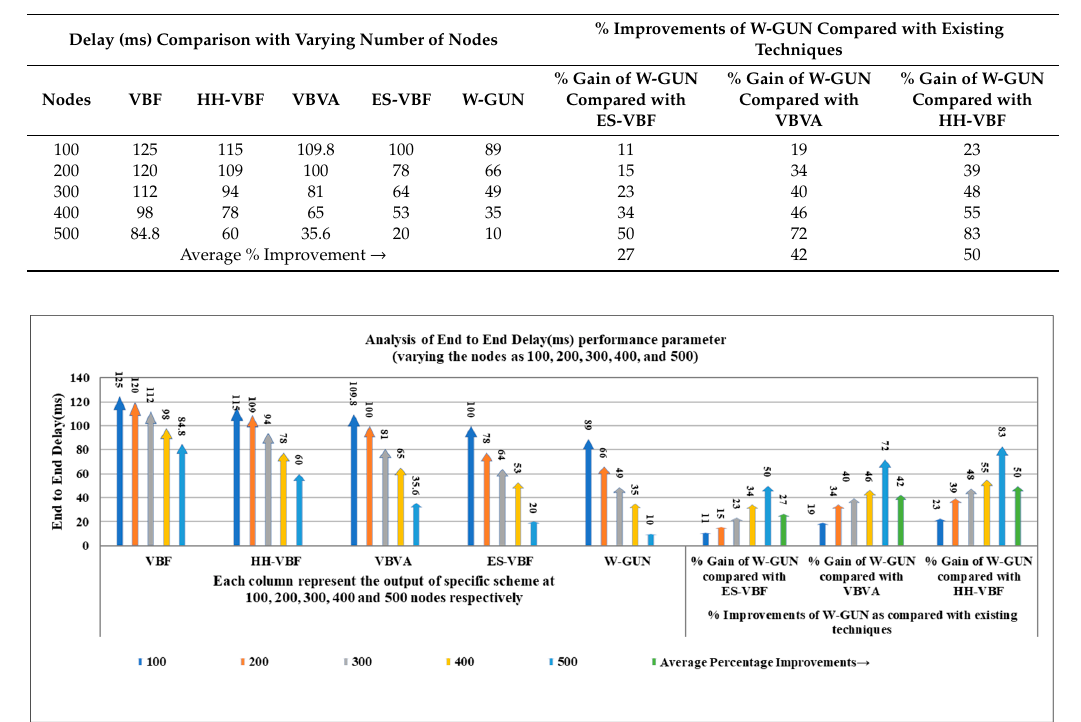
Figure 3. End-to-end delay versus the number of underwater nodes. Table 1. Descriptive performance observation of W-GUN in terms of end-to-end delay.